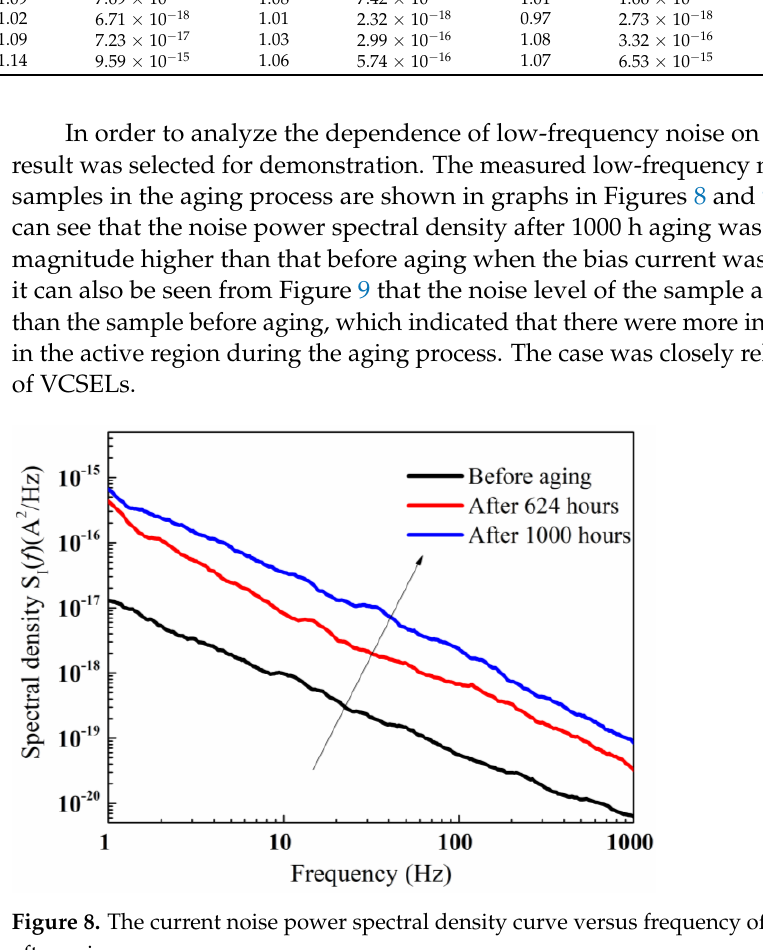
Table 1. The frequency exponential factor and noise amplitude at different forward bias currents.